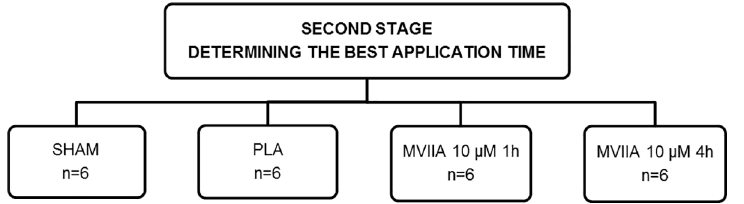
Fig 2. Flow chart of the study design to determine the best application time for omega-conotoxin MVIIA in spinal cord injury. SHAM rats and rats subjected to SCI and injected with placebo (sterile PBS/vehicle, control, designated PLA rats) or MVIIA (designated MVIIA 2.5 μM rats, MVIIA 5 μM rats, MVIIA 10 μM rats, and MVIIA 20 μM